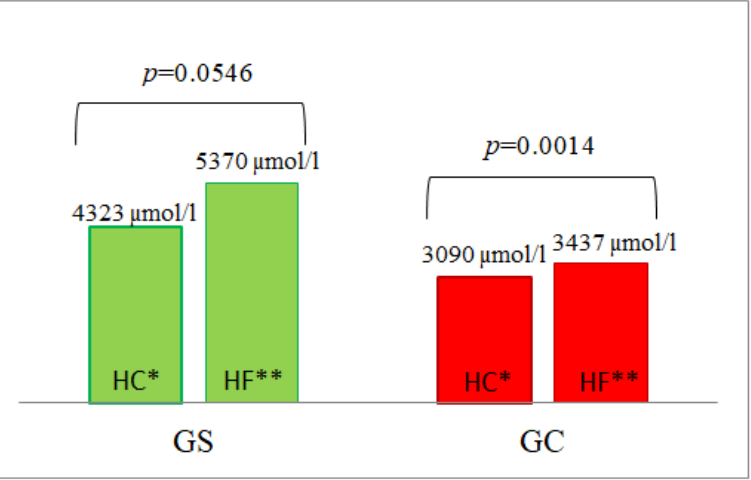
Figure 4. The AUC of homocysteine concentrations in the G S and G C groups after HC and HF meals. The results are presented as the mean values. * difference between the G S (obese/overweight) and G C (normal body weight) groups after HC meal (high-carbohydrate meal ( p = 0.0138)); ** difference between the G S and G C groups after HF meal (high-fat meal ( p = 0.0040)). There were statistically significant positive correlations between BMI and serum homocysteine concentrations following both the HC meal (fasting: p = 0.001; r = 0.6690 and during the second hour of the test p = 0.0010; r = 0.6069) and the HF meal (in the second: p = 0.0012; r = 0.5970 and fourth hour of the test p = 0.0054; r =